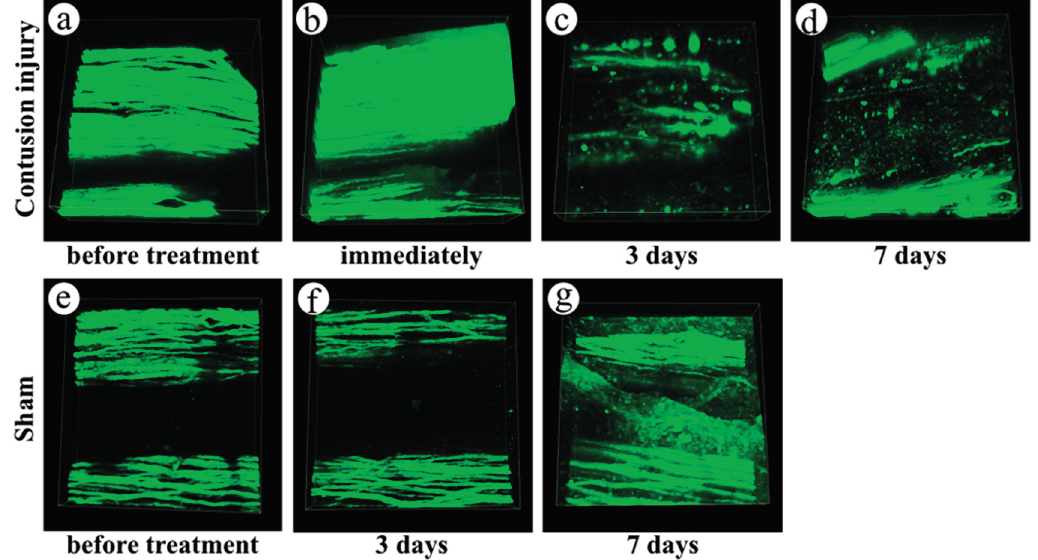
Figure 3. Time-course change of dorsal funiculi axons in YFP-H mice after spinal contusion injury, observed using two-photon excitation microscopy. Spinal cord contusion injury mice were observed before treatment ( a ) and immediately ( b ), three days ( c ), and seven days ( d ) after treatment; sham mice were observed before treatment ( e ), three days ( f ), and seven days ( g ) after treatment. Image acquisition was performed in an area of 509 × 509 μ m at seconds per frame. A three-dimensional volume-rendering image was constructed using the z-stack images. Left side is cranial, and right side is